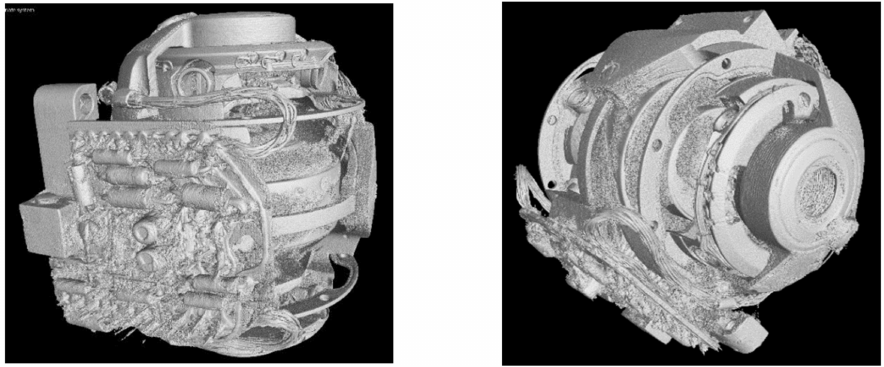
Figure 14. Two views of the iso-surface of the G200 calculated from the 3D volume data set recon- structed by the FBP from the denoised